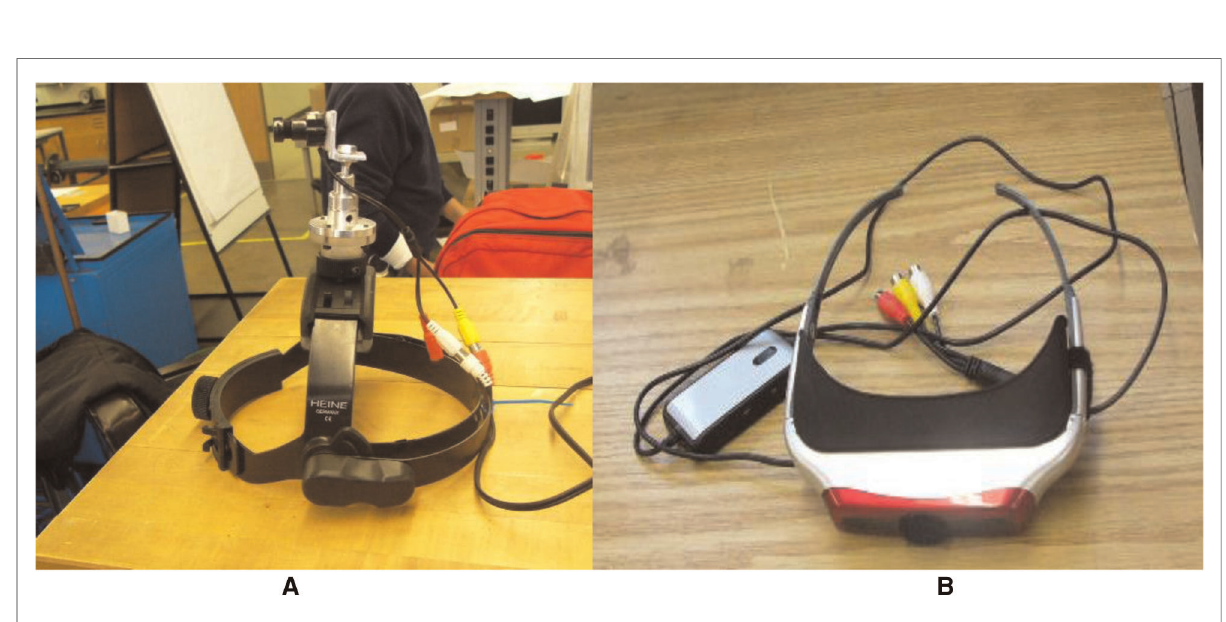
FIGURE 5 ( A ) Helmet with a gimbaled mini-camera mounted on the top. ( B ) Virtual